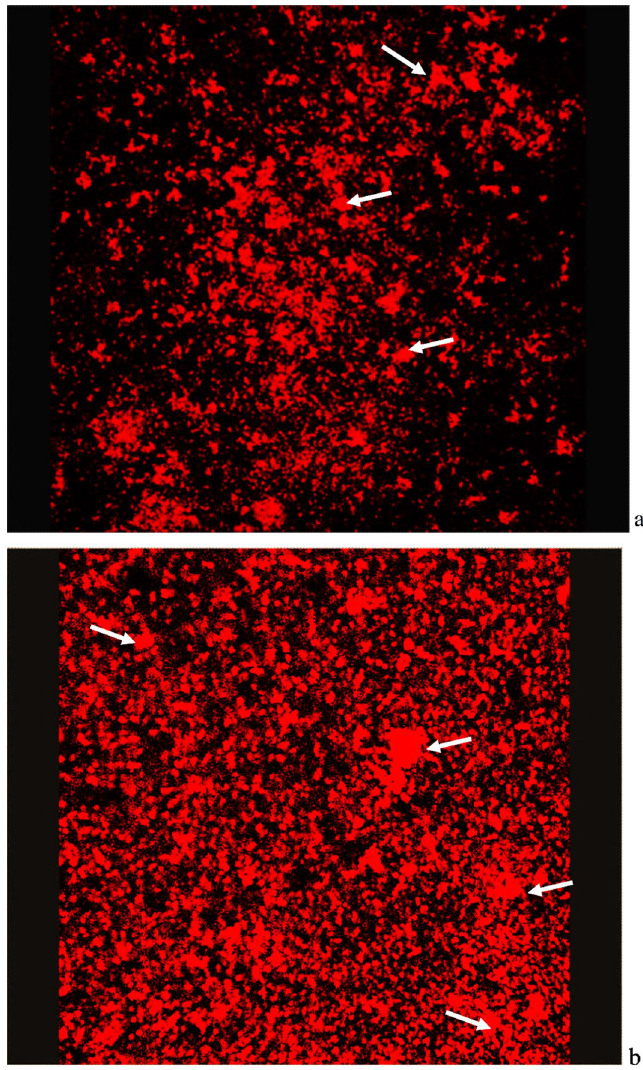
Figure 3. Fluorescent staining, propidium iodide, combined with confocal microscopy showing image of a biofilm formed by Mycoplasma fermentans ATCC19989 in Eaton’s broth medium, after 3 days ( a ) termed early growth stage and 7 days ( b ) termed late growth stage. The image was captured using a ×63 objective lens and the lateral dimension was 238 microns × 238 microns. The biofilm formed showed numerous tower structures (indicated by